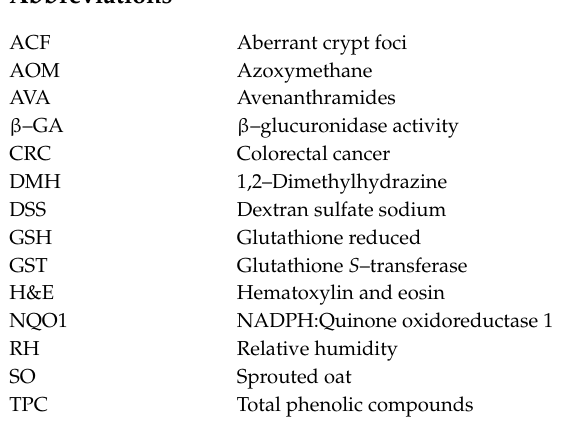
Table S1: Flavonoid and non-flavonoid profile of oat seed and SO obtained by the UPLC-QTOF